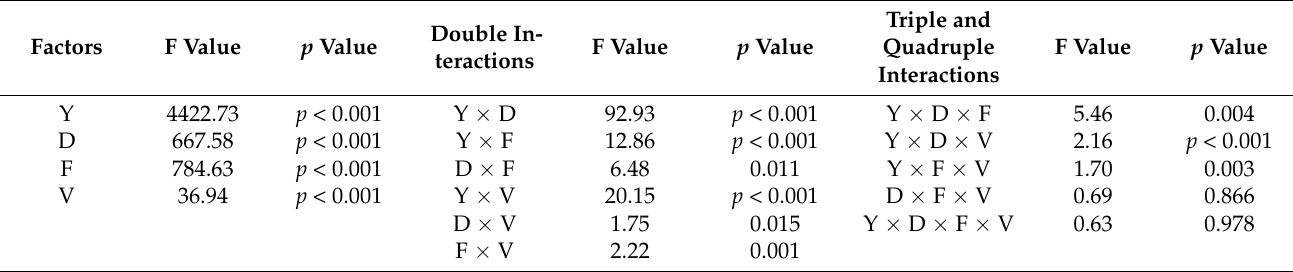
Table 4. The impact of the experimental factors on the production of spring